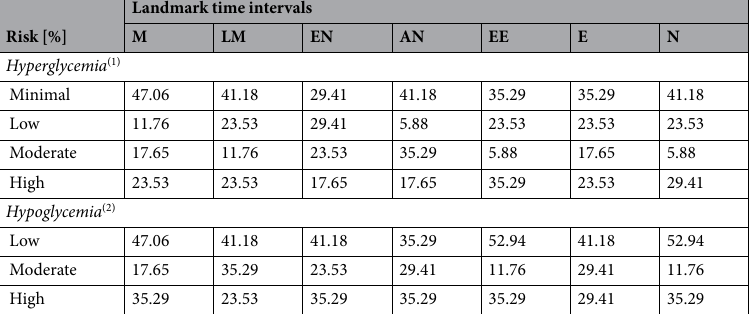
Table 1. Percentages of patients at different risk levels of hypo- and hyper-glycemia when considering the entire monitoring period (n = 17). Abbreviations: M, Morning; LM, Late-morning; EN, Early-noon; AN, Afternoon; EE, Early-evening; E, Evening; N, Night. (1) Risk levels are defined by the Low Glucose Index (LGI): minimal risk for hypoglycemia (LGI less than 1.1); low-risk (LGI between 1.1 and 2.5); moderate-risk (LGI between 2.5 and 5); high-risk (LGI greater than 5). (2) Risk levels are defined by the High Glucose Index (HGI): low-risk (HGI between less than 4.5); moderate-risk (HGI between 4.5 and 9); high-risk (HGI greater than